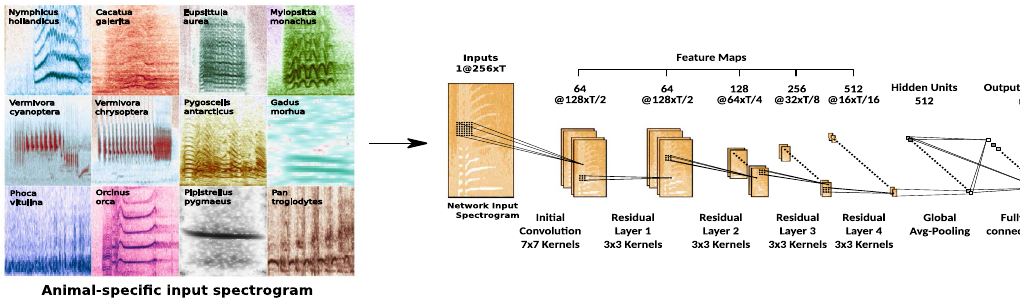
Figure 2. ANIMAL-SPOT Network Architecture (created via Inkscape 39 , Version